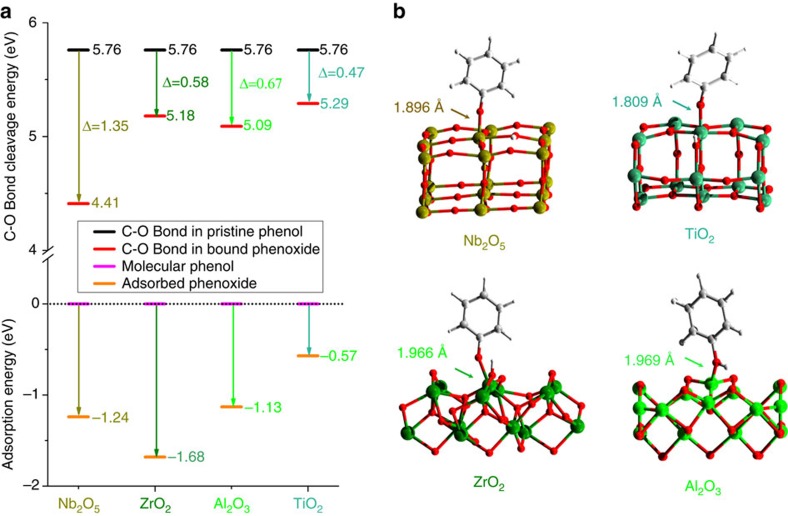
Calculated energies and views of the optimized structural models for phenol binding on catalyst surfaces.(a) Calculated energies for phenol adsorption (that is, a combination of deprotonation of Caromatic–OH to form phenoxide bound to the vacant surface metal sites and the formation of surface –OH groups) and disassociation of the C–O bonds upon adsorption over Nb2O5, ZrO2, Al2O3 and TiO2. (b) Views of the corresponding DFT-optimized structural models for the phenoxide bound on Nb2O5(001), ZrO2(010), Al2O3(110) and TiO2(101) surfaces.